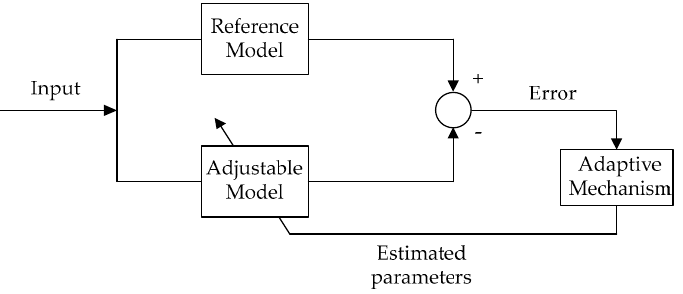
Figure 6. Principle of the model reference adaptive system method for online parameter identification.